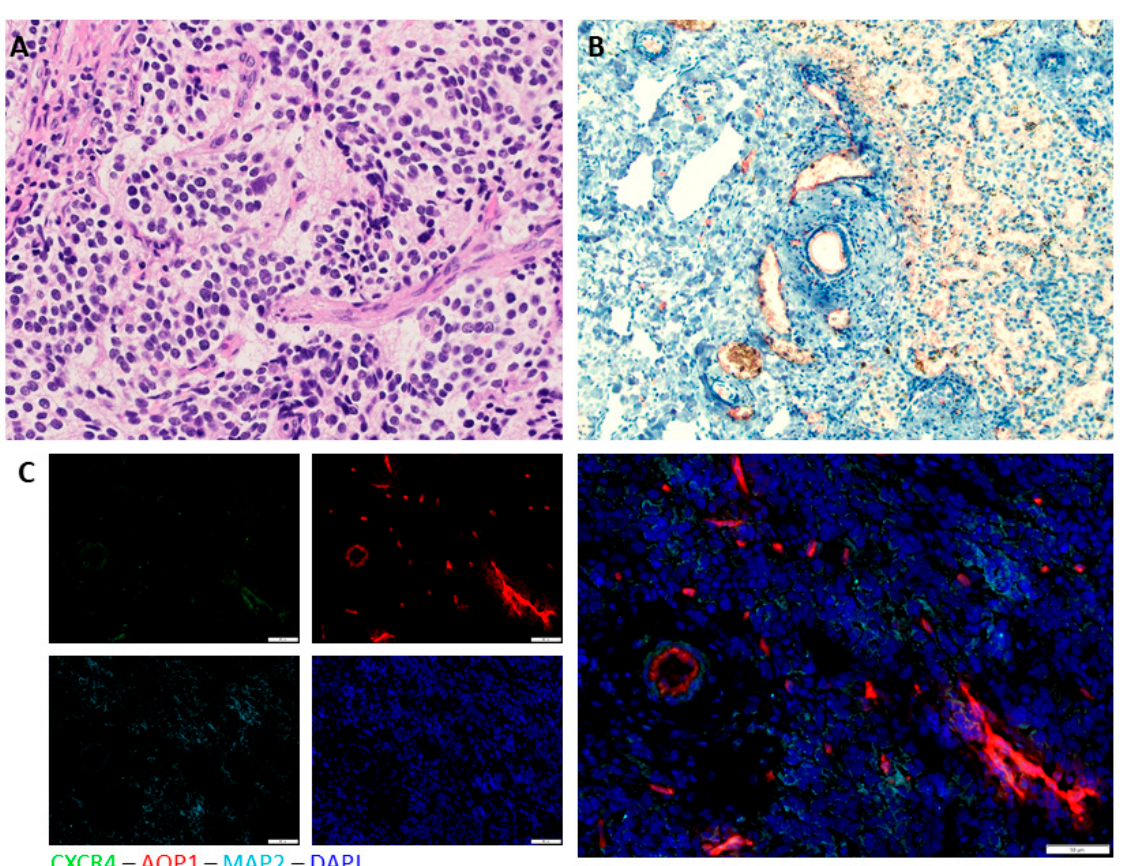
Figure 2. H&E (Hematoxylin and Eosin) and immunohistochemical staining of primary tumor and metastases. ( A ) H&E staining of primary tumor shows histomorphological characteristics of poorly differentiated, Schwannian stroma poor neuroblastoma; ( B ) aquaporin 1 (AQP1) immunohistochemical staining and hematoxylin counterstaining of the liver metastases reveals dissolution of the periportal structure in the tumor-infiltrated regions. AQP1 positivity is observed in metastatic areas as well as in vascular endothelium (which can serve as an internal positive control). ( C ) AQP1, CXCR4 and MAP2 (microtubule associated protein) immunofluorescence staining of the primary tumor. Nuclei staining with DAPI (4 ′ ,6-diamidin-2-phenylindol) . Next to AQP1, which is expressed in vascular structures as well as specific tumor areas, there is some expression of CXCR4 as a marker for metastatic homing as well as MAP2 expression in some areas indicating a more mature neuronal phenotype. Overall, tumor and metastases express experimental features that can be associated with a more aggressive phenotype.